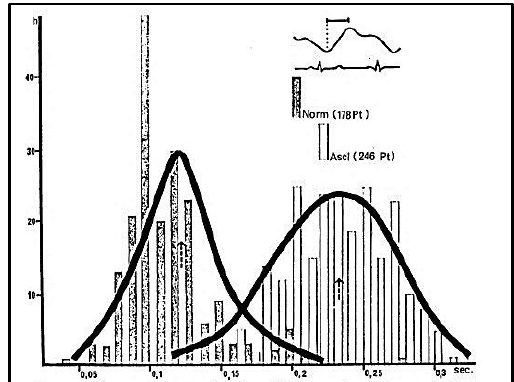
Fig.2: Diagrammatic presentation of compiled data on time (in seconds) between the onset of a phase and highest (first) peak, averaged from 100 phases of each patient (Pt) of 178 normal (Norm) subjects and 246 patients with proven cerebral arteriosclerosis (Ascl). All of which had been submitted to carotid arteriography. Unit of the Y-axis is the incidence or case number (frequency)